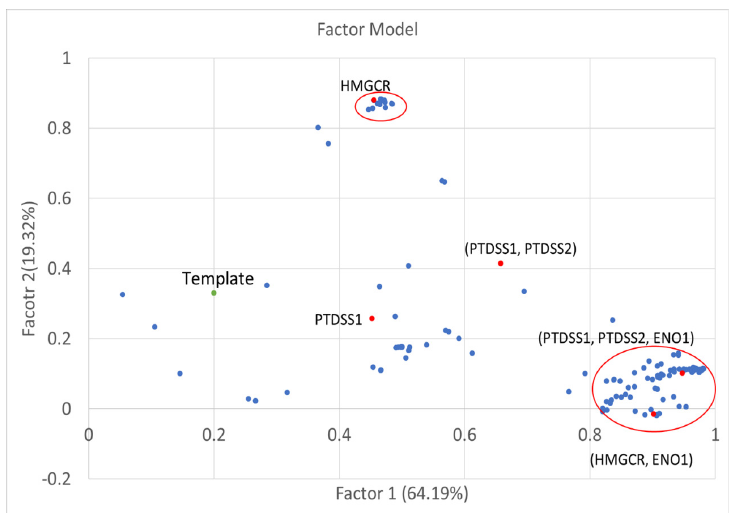
Figure 8. Membership grades for two-target combinations. First and second factor loadings of the identified anticancer target genes and antimetabolites. The template is the green dot. The first group around Factor 1 in the red circle contained 116 two-target combinations and a three combination of (PTDSS1, PTDSS2, ENO1) comprising anticancer target genes and antimetabolites. The second group around Factor 2 contained 42 anticancer target genes and antimetabolites. Half of these were two-target combinations. These two-target combinations included the enzyme